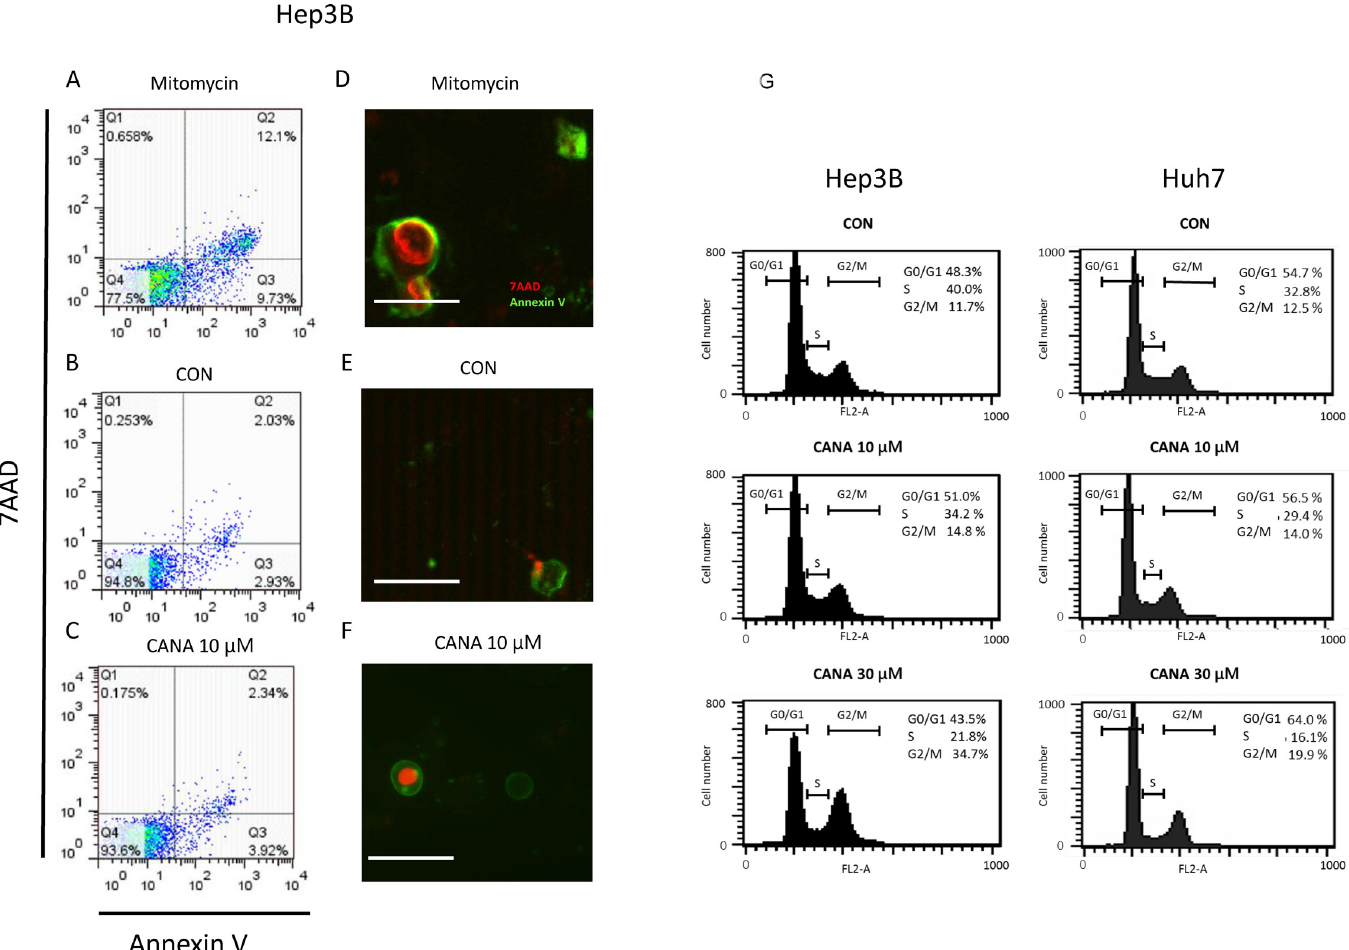
Fig 3. Effects of CANA on apoptosis and cell cycle of Hep3B and Huh7 cells. Apoptosis was evaluated by flow cytometry using 7AAD and annexin V in the A) Mitomycin group, B) CON group, and C) 10 μ M CANA groups. Apoptosis was also evaluated by immunostaining for 7AAD (red) and annexin V (green) in the D) Mitomycin group, E) CON group, and F) 10 μ M CANA group. Scale bar = 50 μ m. G) Cell cycle distribution was evaluated by flow cytometry. Abbreviations: 7AAD, 7-amino-actinomycin D; CON, control; CANA, canagliflozin.